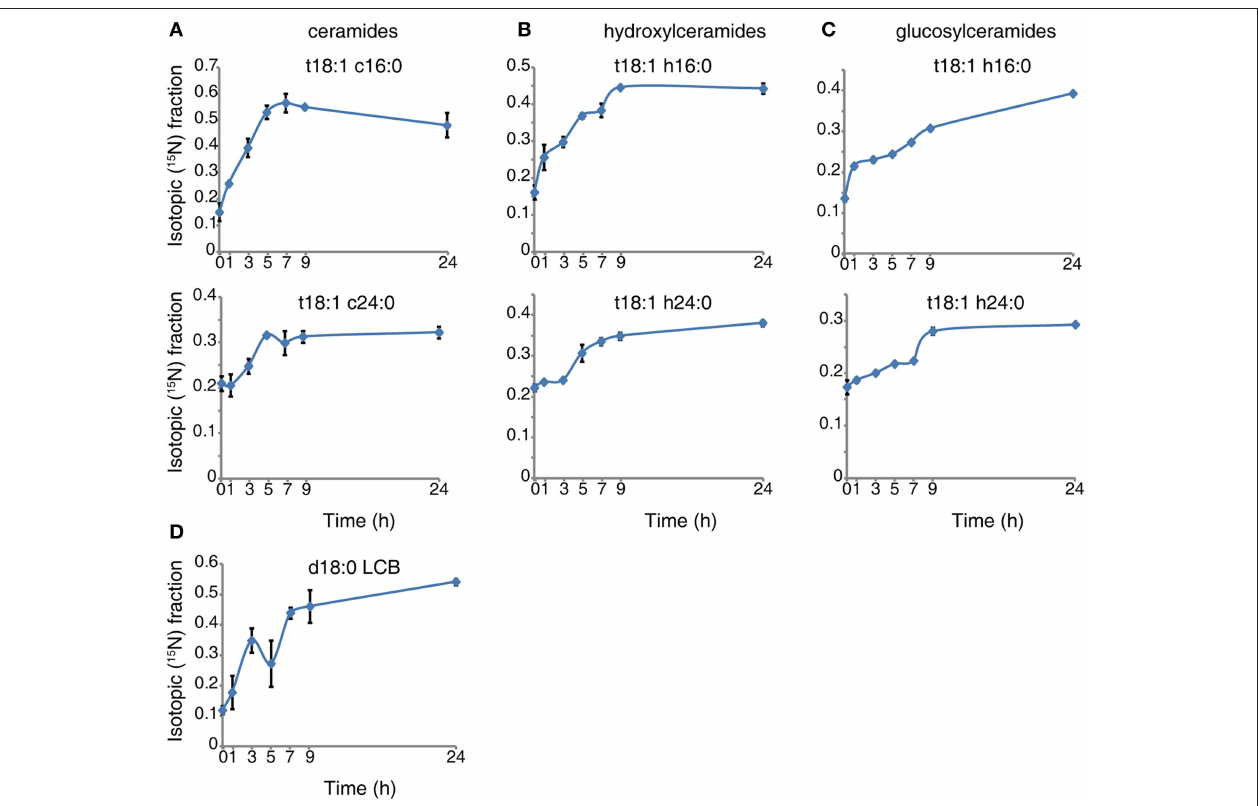
from triplicate biological repeats. The measured sphingolipid species were: ceramide (A) , hydroxyceramide (B) , gluocosylceramide (C) and LCB (D) . LCB and fatty acid in ceramide species represent, LCB; d/t (di/trihydroxy) 18 (18 carbon chain), 1 (one desaturation) followed by fatty acid; c/h/g (non-hydroxyl/hydroxyl/glucosy and hydroxyl) 24 (24 carbon chain), 0 (no